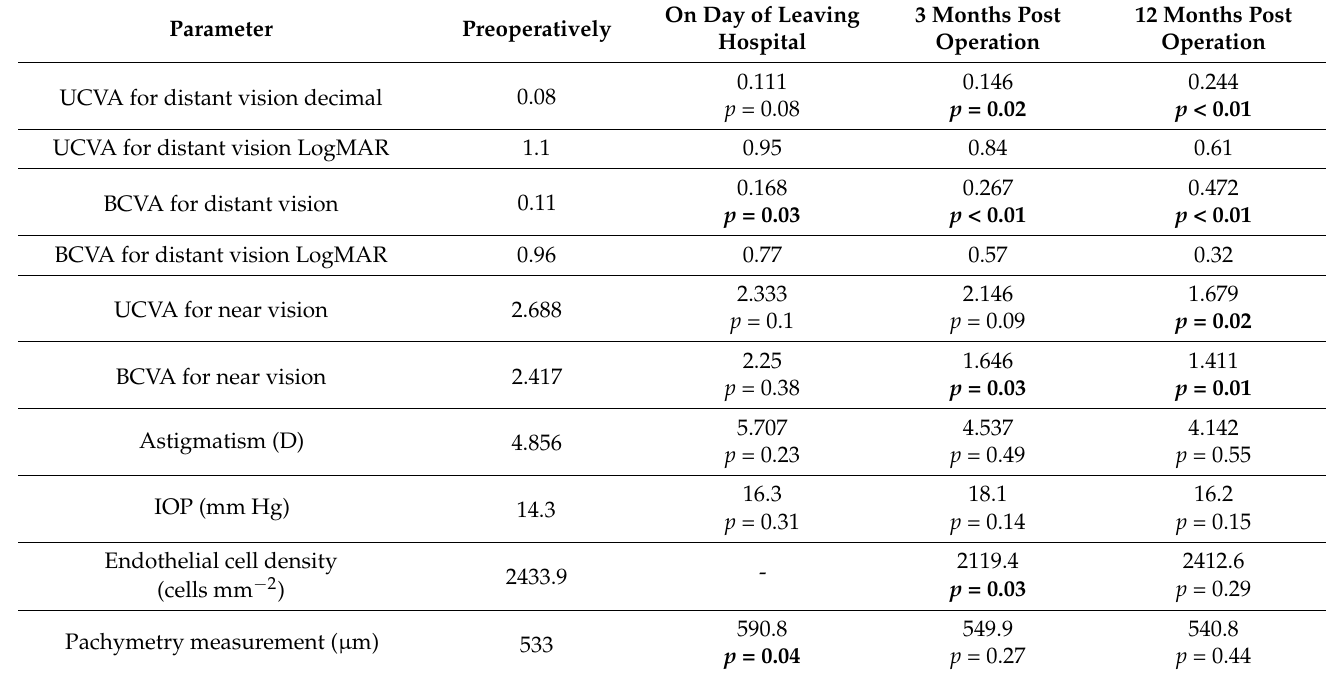
Table 2. Mean values of assessed parameters p values are for comparison of postoperative parameter with preoperative value- Student’s t -test and the Wilcoxon signed-rank